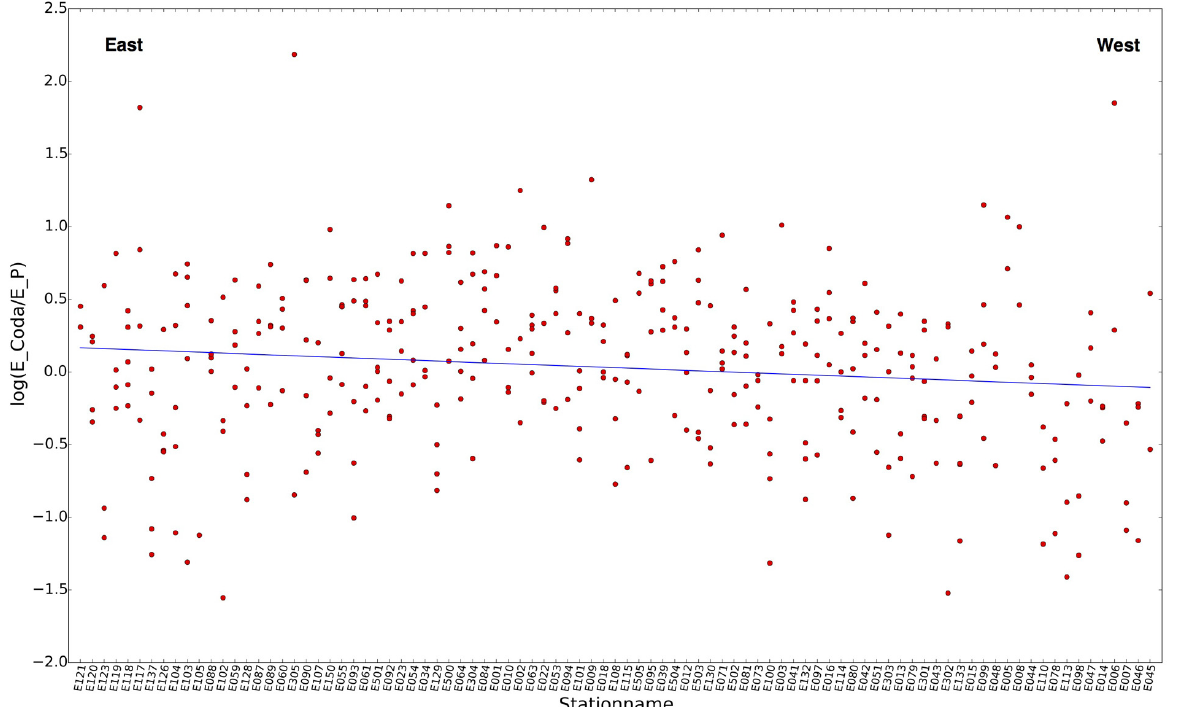
Figure 5. The energy ratio plotted over their respective station from east to west of the volcano. Different values on one station symbolize the mean value of a 45 degree